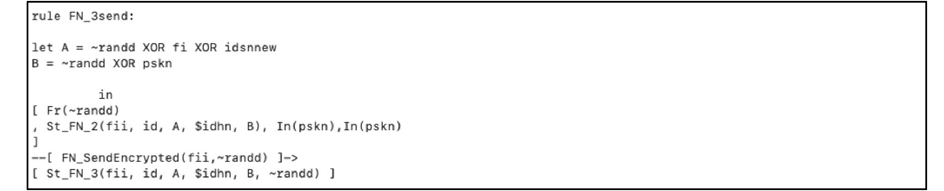
Figure 7. FN send authentication request to the HN .